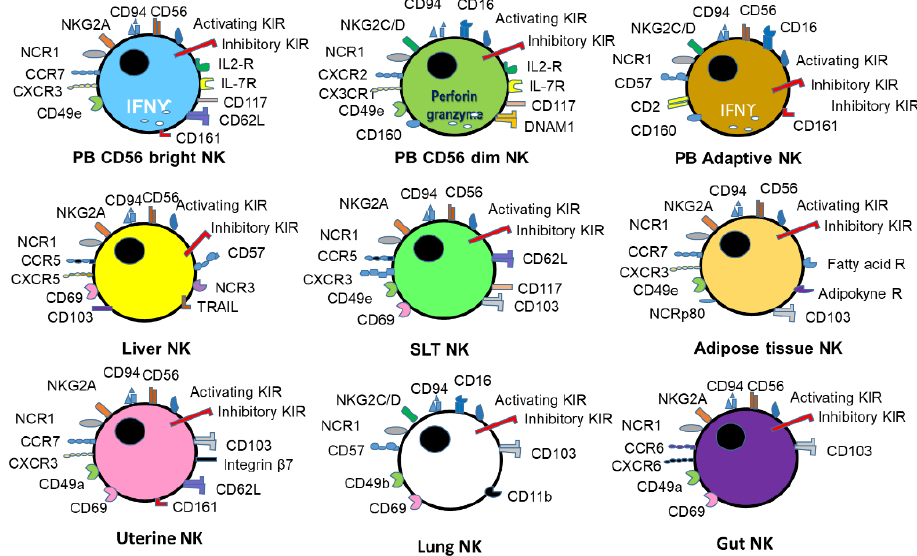
Figure 1. Different NK cell populations. The figure represents some NK cell populations. Peripheral blood (PB) circulating NK cells are defined by CD56 or CD16 antigen. The adaptative NK cell can present different antigens depending on the stimulating factors, CD16 or CD56. However, they may express NKG2C/D preferentially over NKG2A. For the rest of the subpopulations, the figure includes the most relevant. The expression of receptors is dependent upon the tissue. The term SLT refers to NK cells present in small lymphatic tissue.